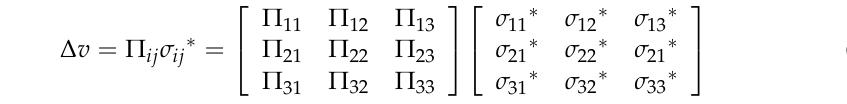
Figure 4 . ( a ) smooth curve obtained by multipeak fitting; ( b ) noise distribution; ( c ) simulated spectrum with introduced noise.